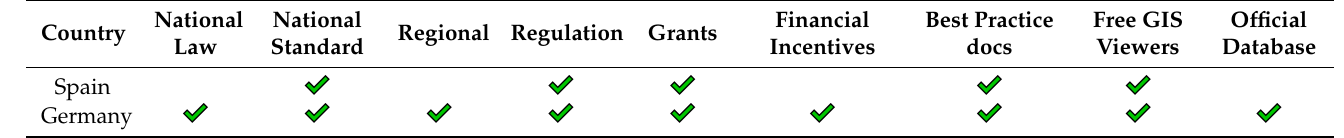
Table 5. State of the art of the legal framework in every study site country.